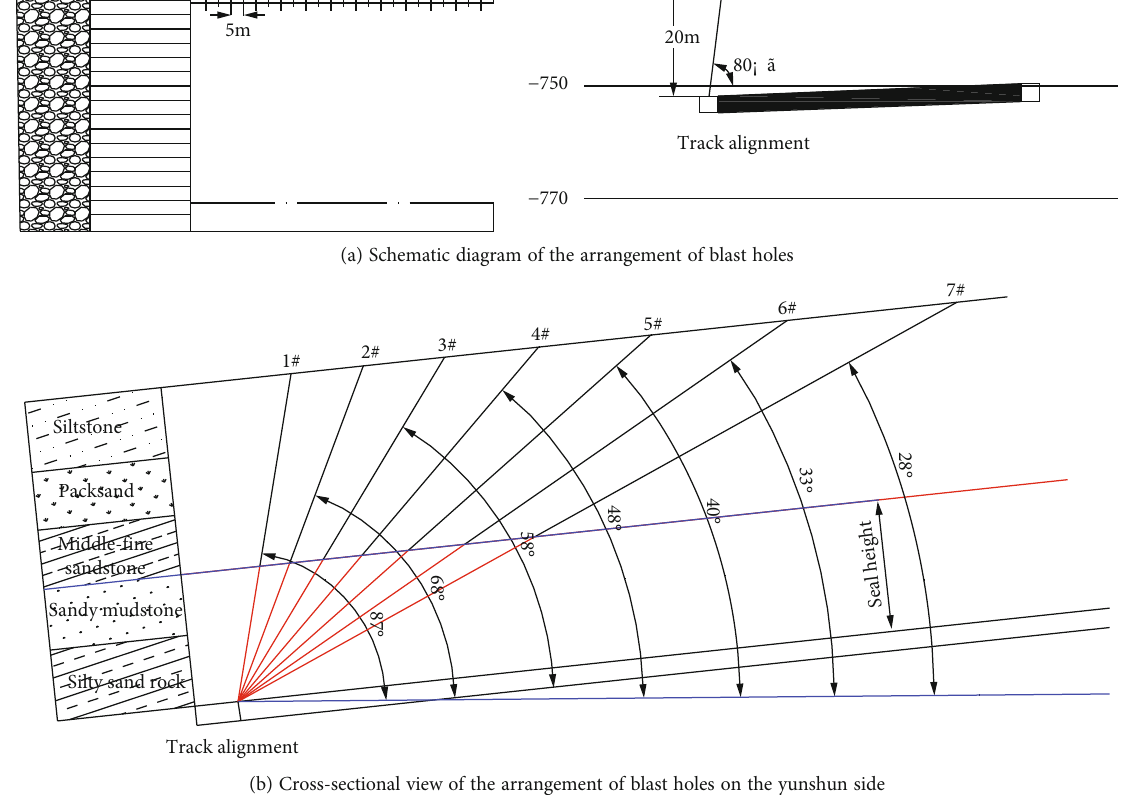
Figure 9: Design of deep hole cutting top discharge blasting scheme for return mining roadway.